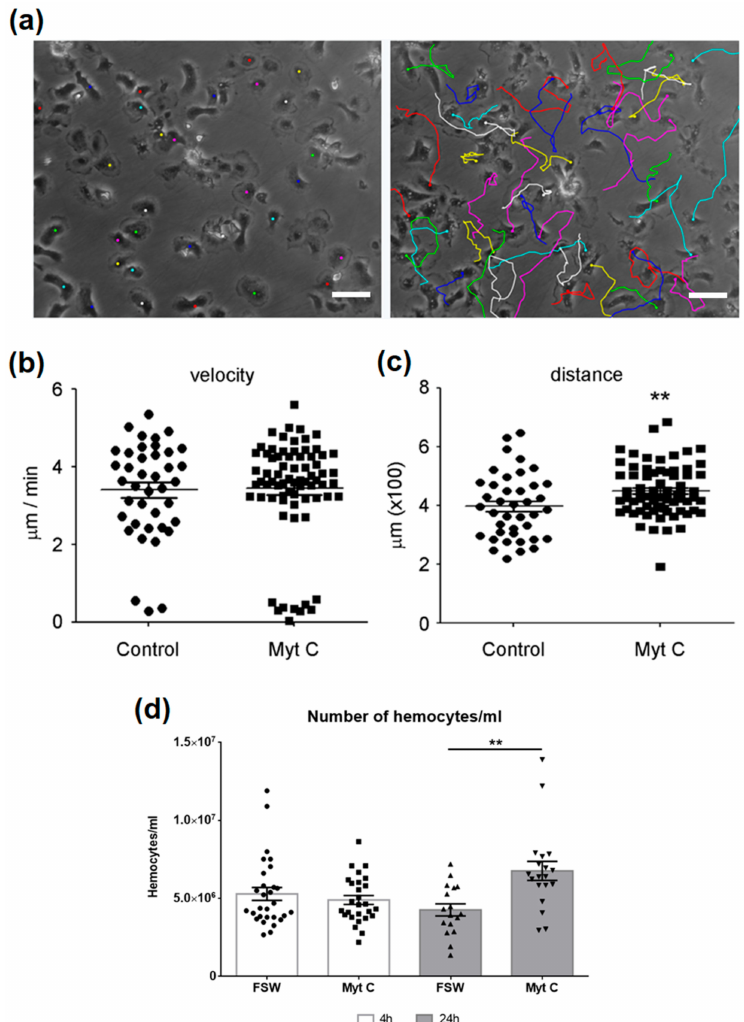
Figure 4. ( a ) Tracking of individual cell movements. The displacement of single cells is marked with a di ff erent color. Scale bar 50 µ m. ( b ) Mean velocity of cell displacement ( µ m / min) after 3 h of stimulation. ( c ) Accumulated distance traveled by the cells during 3 h. ( d ) Number of hemocytes counted after 4 h and 24 h of in vivo treatment with myticin C. Asterisks denote significant di ff erences at p < 0.01